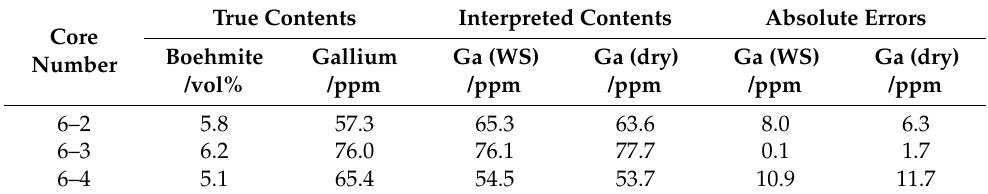
Table 6. True and interpreted gallium contents of gallium-rich cores from No. 6